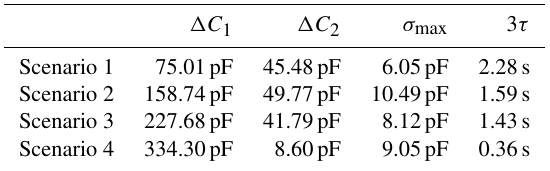
Table 2. Experimental results for significant parameters of the man- ufactured